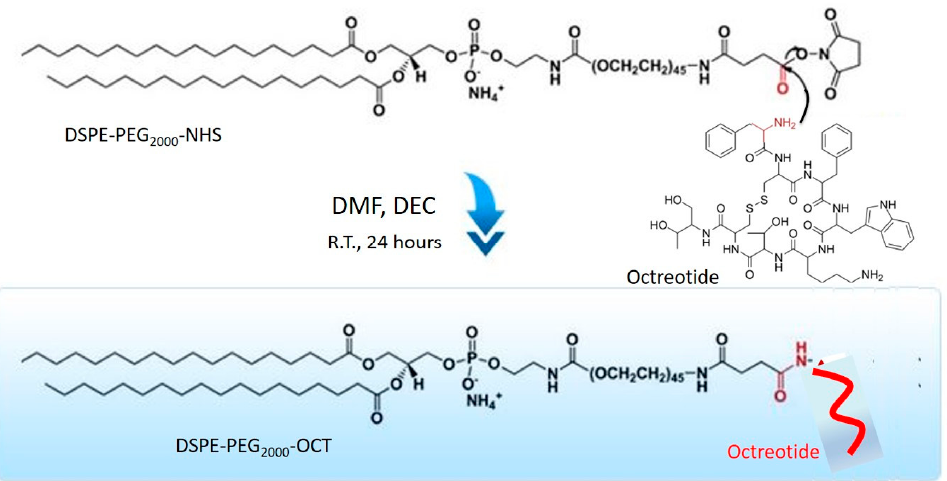
Figure 1. Synthesis scheme for 1,2-distearoyl-sn-glycero-3-phosphoethanolamine- N -[carboxy(polyethylene glycol)- 2000 ] (DSPE-PEG 2000 -OCT).